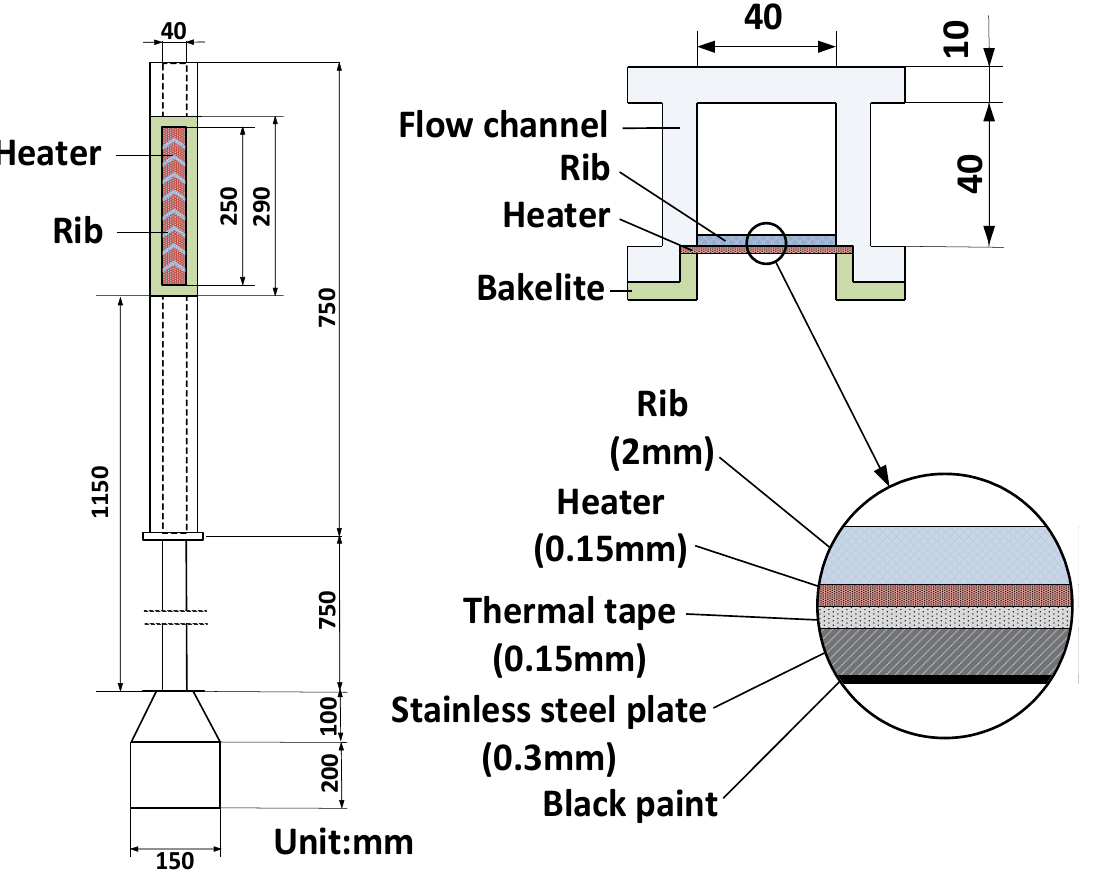
Figure 2. Drawing of the test channel.